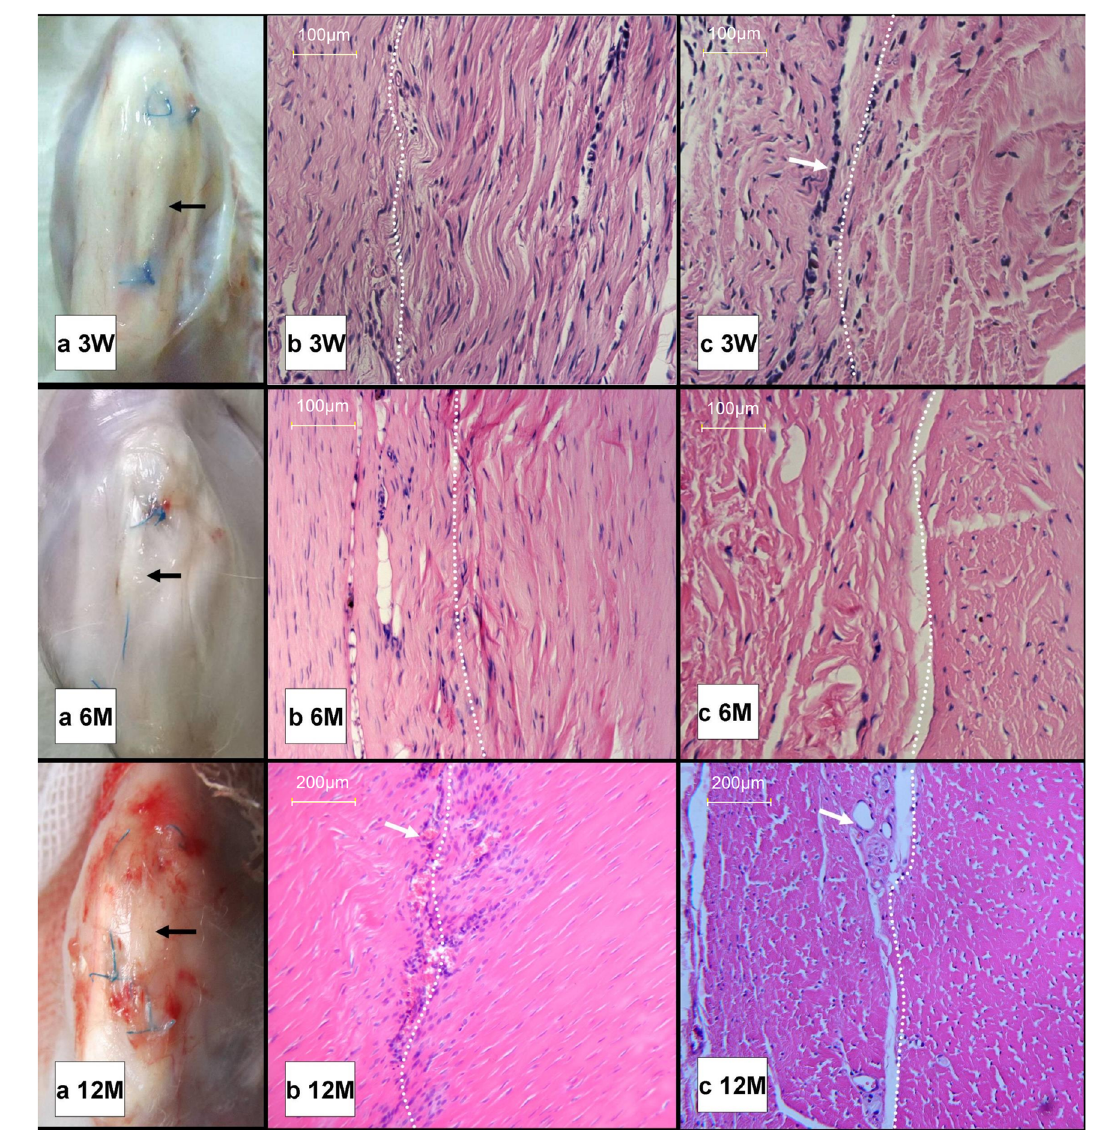
Fig. 11 In vivo host cytocompatibility and histocompatibility results. a Gross observation at 3 weeks, 6 months, and 12 months after implantation. The implants are indicated by black arrows. b , c Longitudinal section and cross section of hematoxylin and eosin (H&E) staining (magni fi cation ×200). The right area of the dashed line